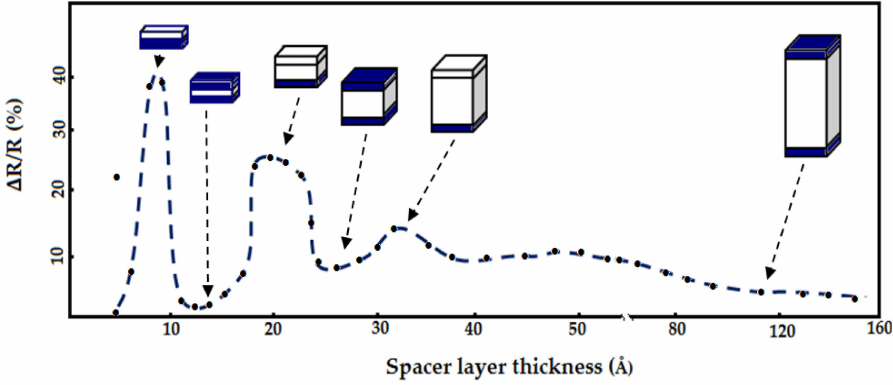
Figure 13. Magnetoresistance versus Cu spacer thickness for Co/Cu GMR multilayers at room temperature by Parkin et al. [48].